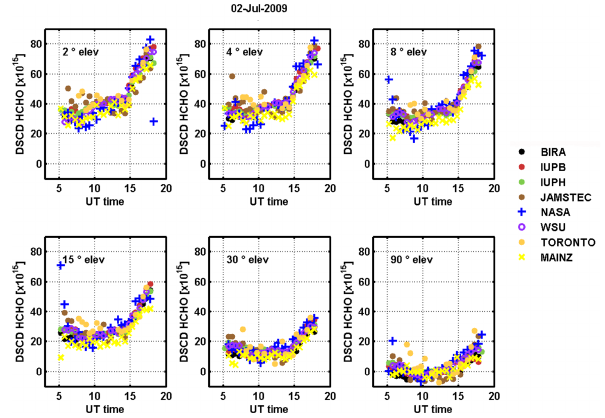
Fig. 4. Diurnal evolution of the HCHO DSCD measured on 2 July 2009 and averaged in 30-min bins, for the different instru- ments involved in the intercomparison. Units are moleccm − 2 .